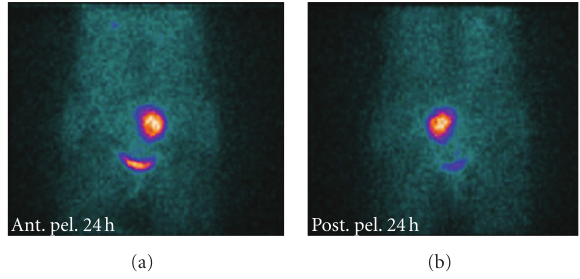
Figure 3: I-MIBG scintigraphy showing accumulation of radio- pharmaceutical in the left paramedian site of the